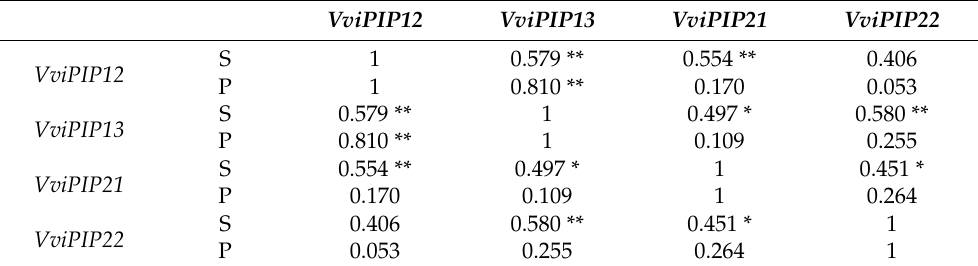
** Correlation is significant at the 0.01 level. * Correlation is significant at the 0.05